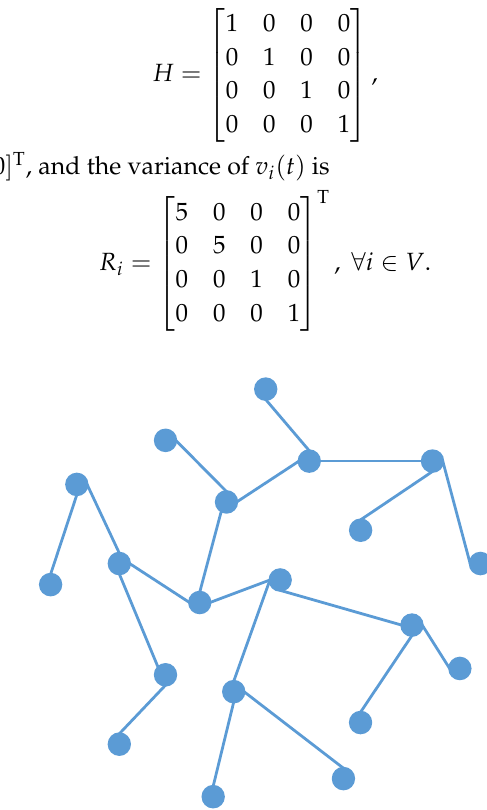
Figure 1. A sensor network with 20 nodes.